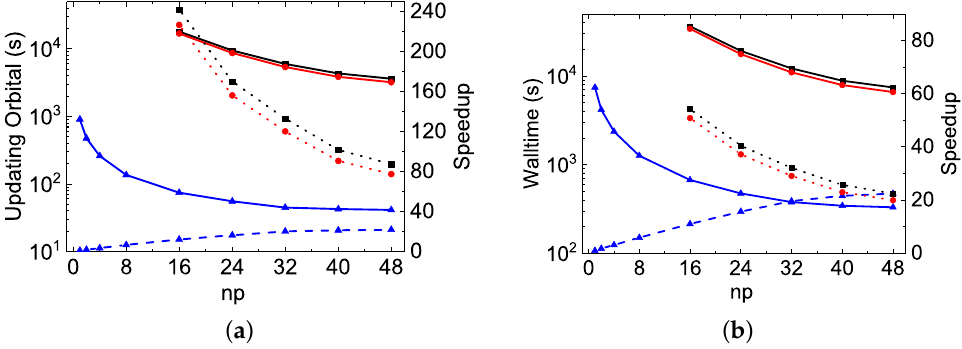
Figure 6. MPI performances for the Be I 15( spdf g )14( hi )13( kl )-SCF calculations. ( a ) Solid (left y axis): orbital updating CPU times (T in s) for rmcdhf_mpi (squares), rmcdhf_mem_mpi (circles), and rmcdhf_mpi_FD (triangles) codes versus the number of MPI processes ( np ). Dashed line (right y axis): speed-up factors of rmcdhf_mpi_FD (triangles) calculated as the ratios of T ( np = 1 ) to others. Dotted line (right y axis): speed-up factors of rmcdhf_mpi_FD relative to rmcdhf_mpi (squares) and to rmcdhf_mem_mpi (circles), calculated as T ( rmcdhf_mpi )/ T ( rmcdhf_mpi_FD ) and T ( rmcdhf_mem_mpi )/ T ( rmcdhf_mpi_FD ), respectively. ( b ) Same as in ( a ), but for the